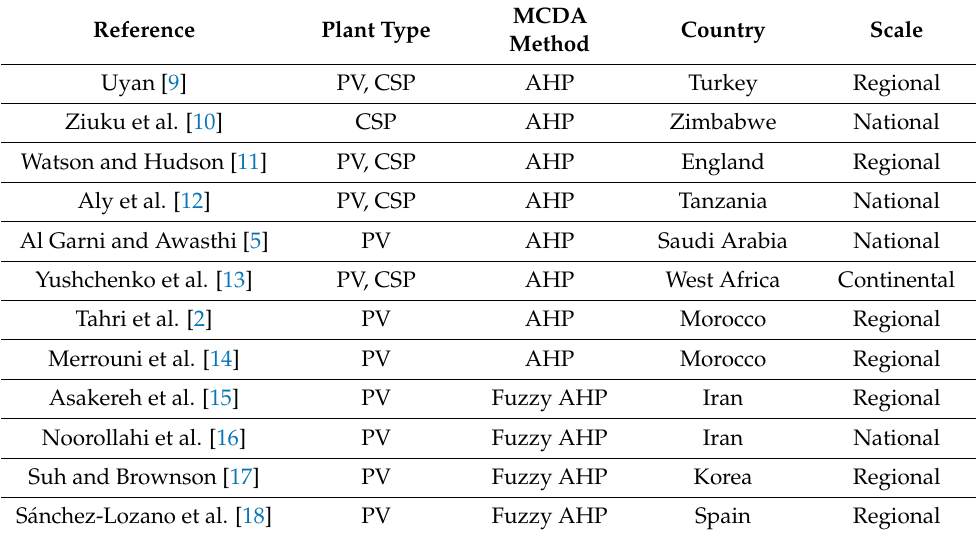
Table 1. Summary of previous studies that analyzed site suitability for solar power plants using geographic information systems (GIS) and the analytic hierarchy process